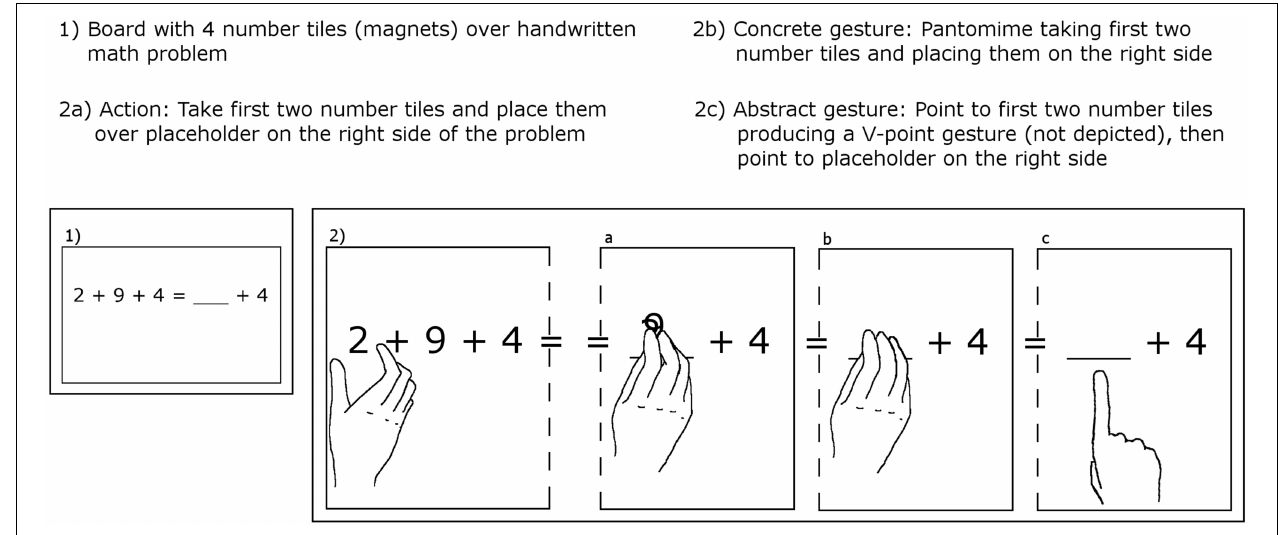
FIGURE 1 | Illustration of experimental conditions in Novack et al. (2014). Panel 1: Sample problem. Panel 2 a–c: right side of equation in the three experimental